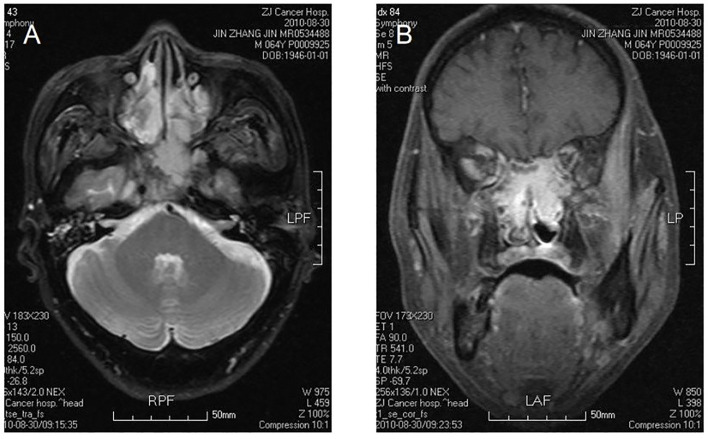
Bilateral nasal cavity and sinus osteosarcoma. MR image shows bilateral postirradiation osteosarcoma in a mixture of nasal and paranasal sinuses. In magnetic resonance imaging, the signal was isointensity in T1 and high in T2 weighted images in bilateral postnaris, ethmoidal cellules and sphenoid sinus. The lesion violates medial orbital wall and musculus rectus medialis of left eye with irregular morpha. There was evident intensification after contrast. The signal of skull bone is abnormal (A, B).